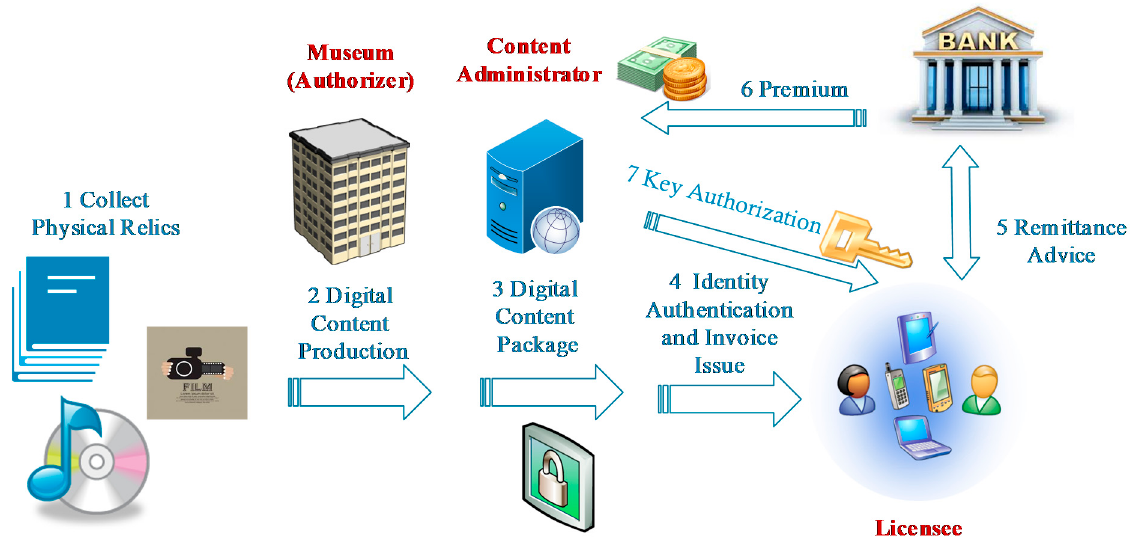
Figure 1. The digital direct authorization model of museum collections.